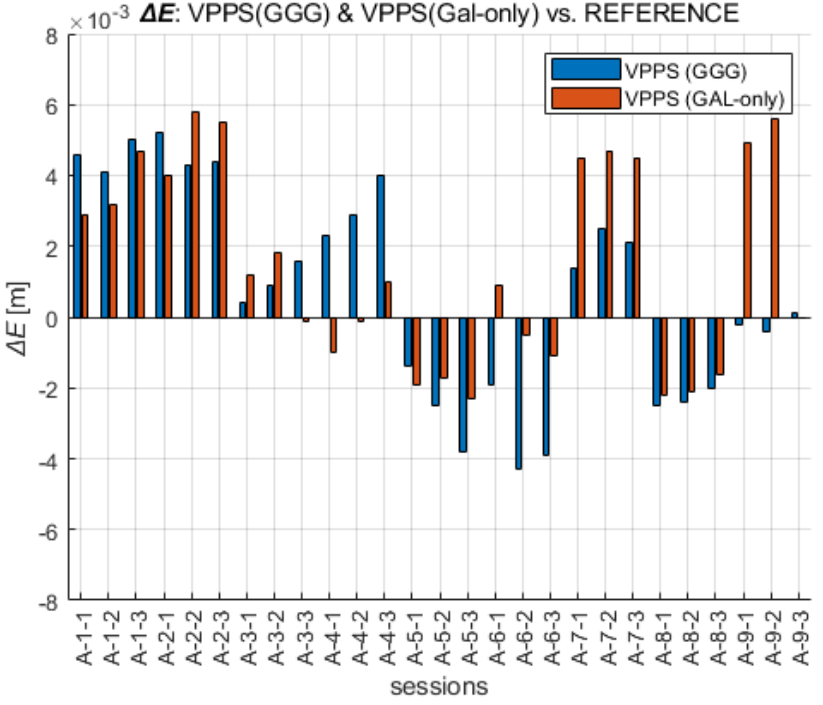
Figure 9. Easting coordinates obtained with VPPS using GGG (cyan) and GAL-only (green) observations given as difference to the REFERENCE value.